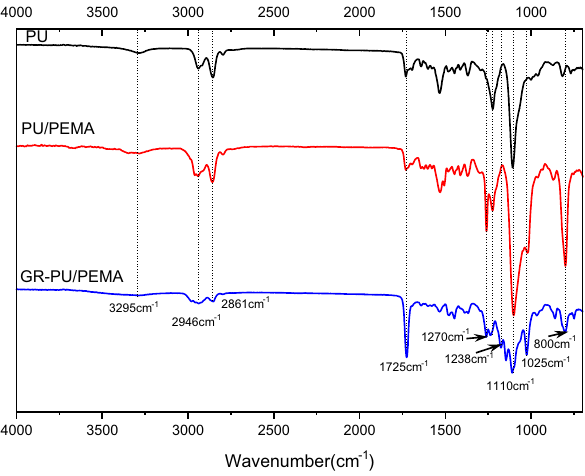
Figure 3: FT - IR spectra of PU, PU/PEMA, and GR